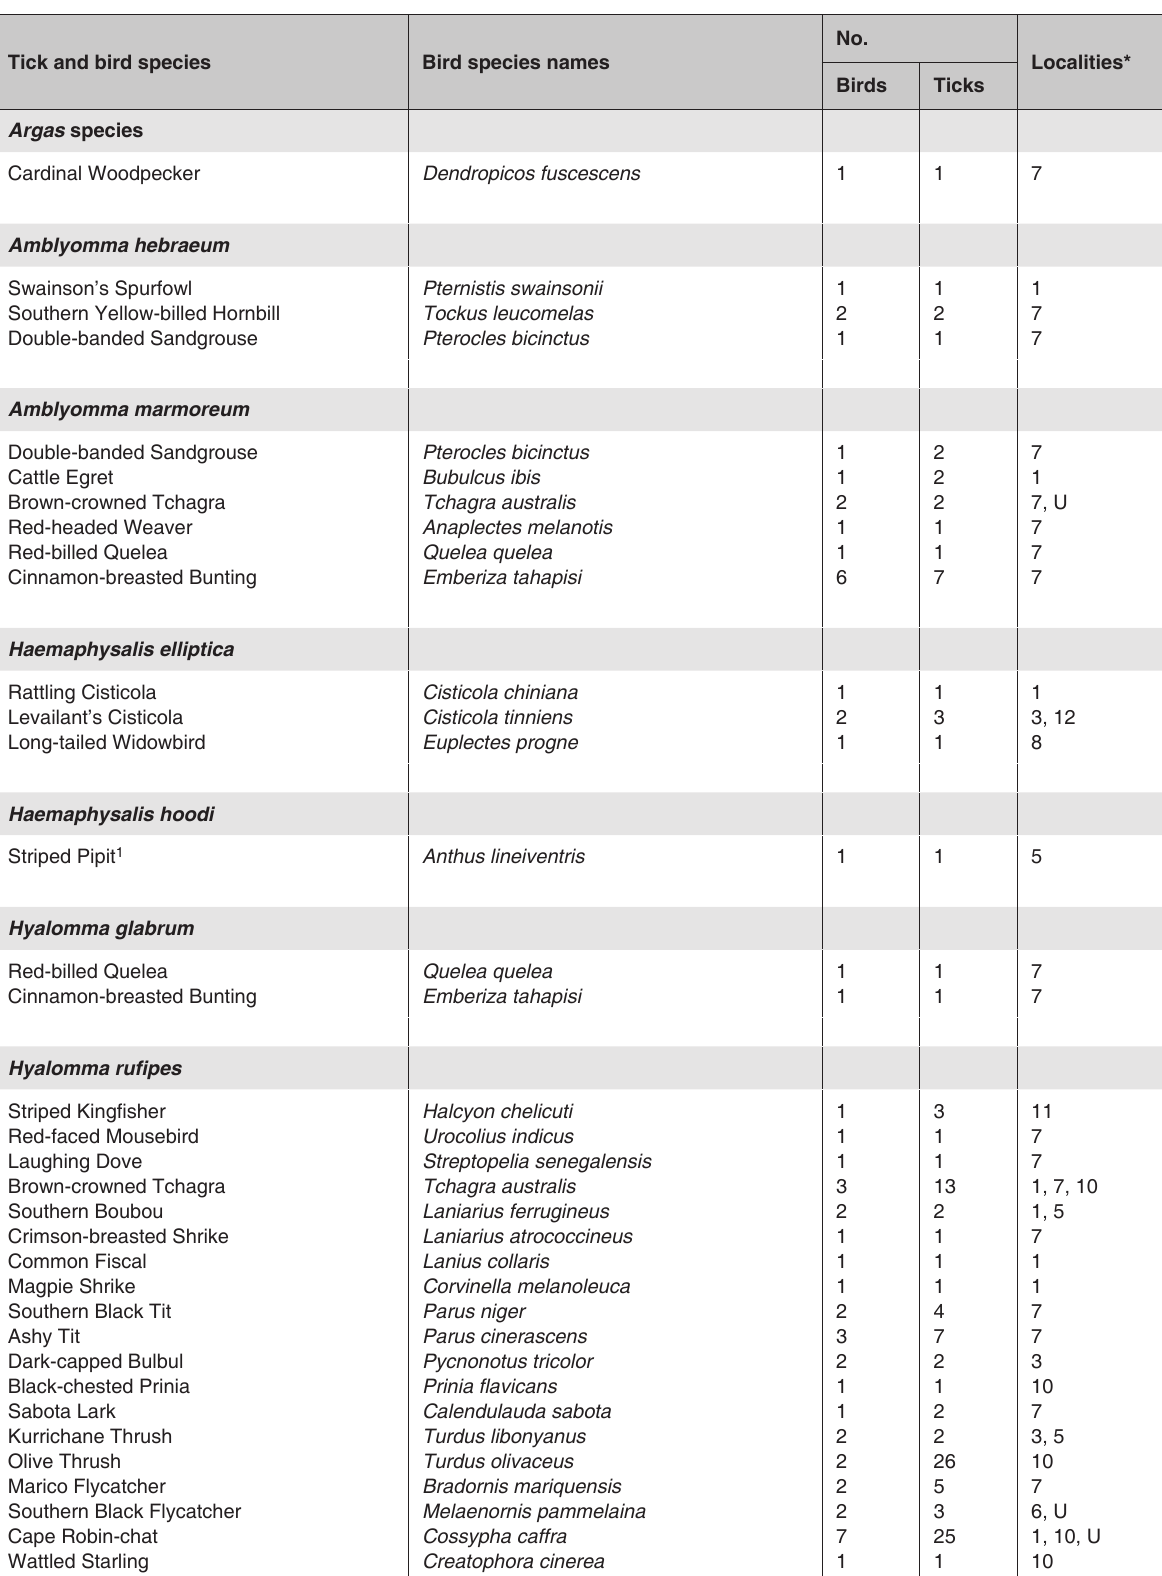
TABLE 2 Ticks collected from 83 infested birds in the northern provinces of South Africa (immature stages when not otherwise indi-